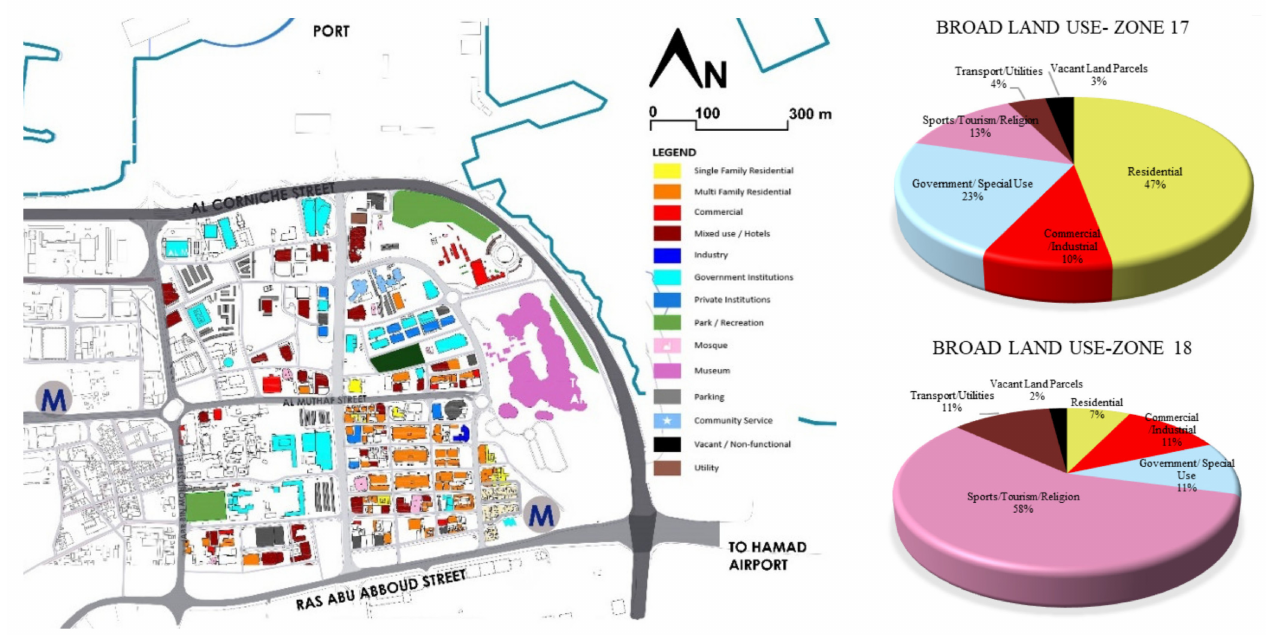
Figure 5. Land use map and broad land use percentage in zones 18 and 17